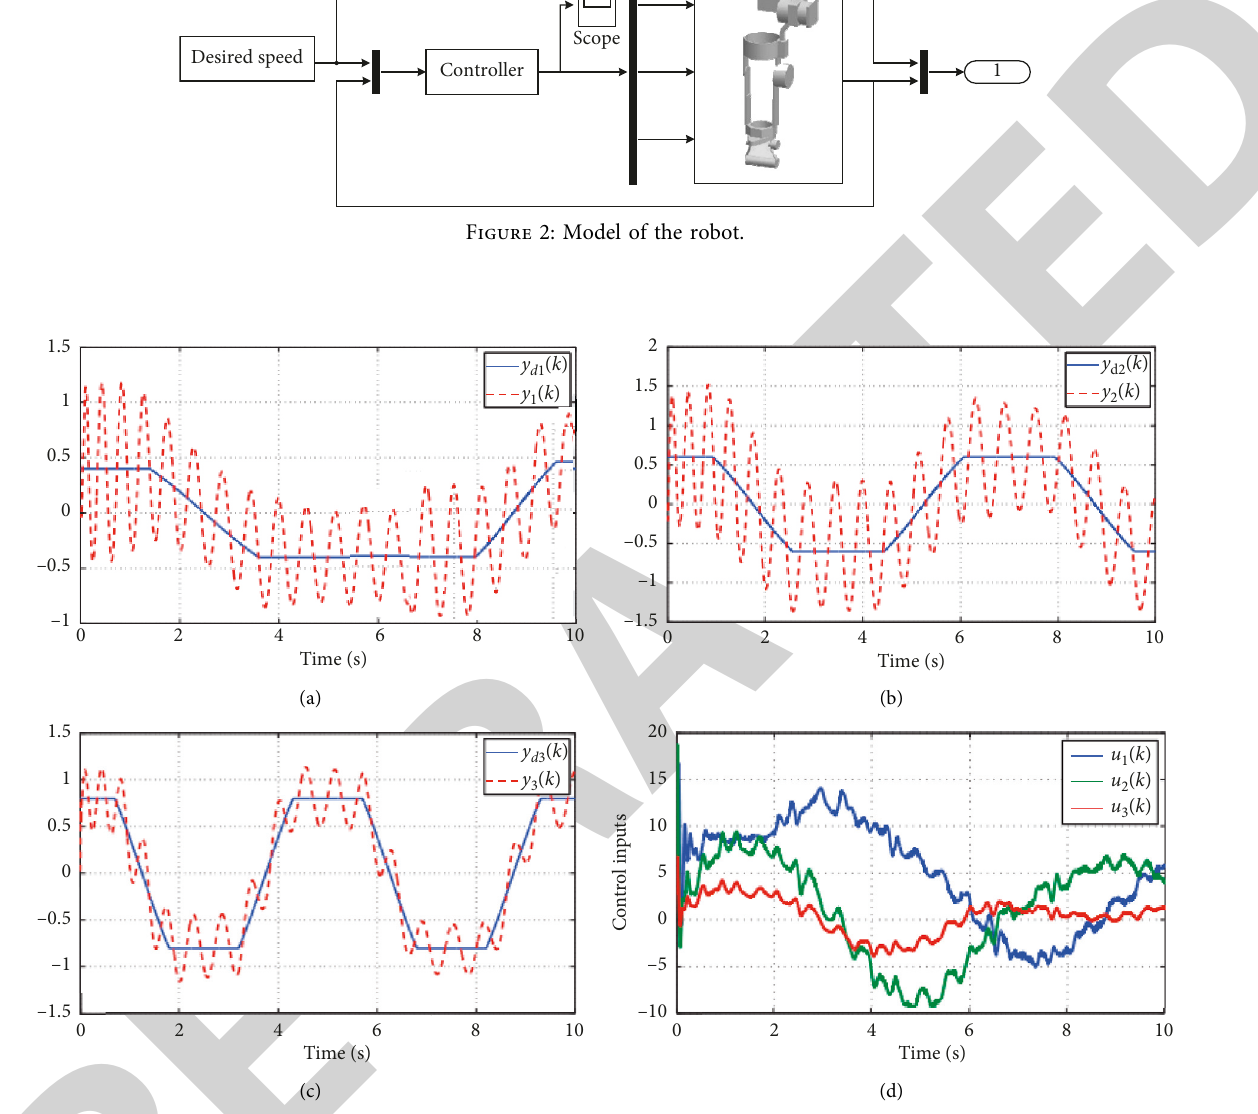
Figure 3: The model-free adaptive control simulation results of three joints under control. (a) Tracking performance of y performance of y 2 ( k ). (c) Tracking performance of y 3 ( k ). (d) Control inputs of u 1 ( k ), u 2 ( k ), and u 3 ( k ).